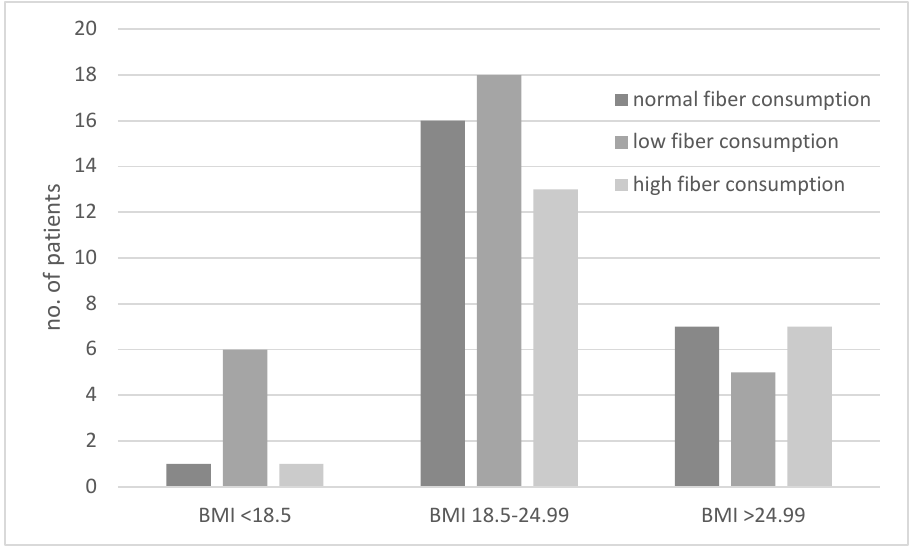
Figure 3. Comparison of dietary fiber intake in underweight (body mass index (BMI) < 18.5 kg/m 2 ), normal-weight (BMI 18.5–24.99 kg/m 2 ), and excessive-weight (BMI > 24.99 kg/m 2 ) subjects.